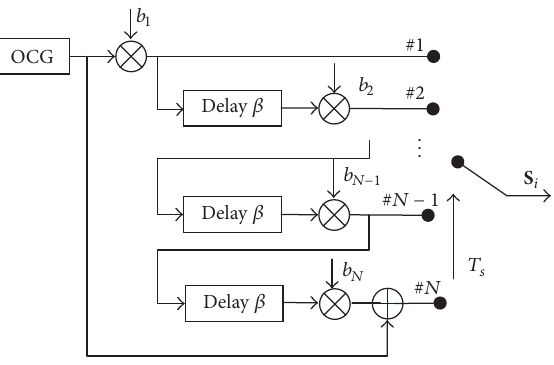
Figure 3: Block diagram of the proposed system transmitter.